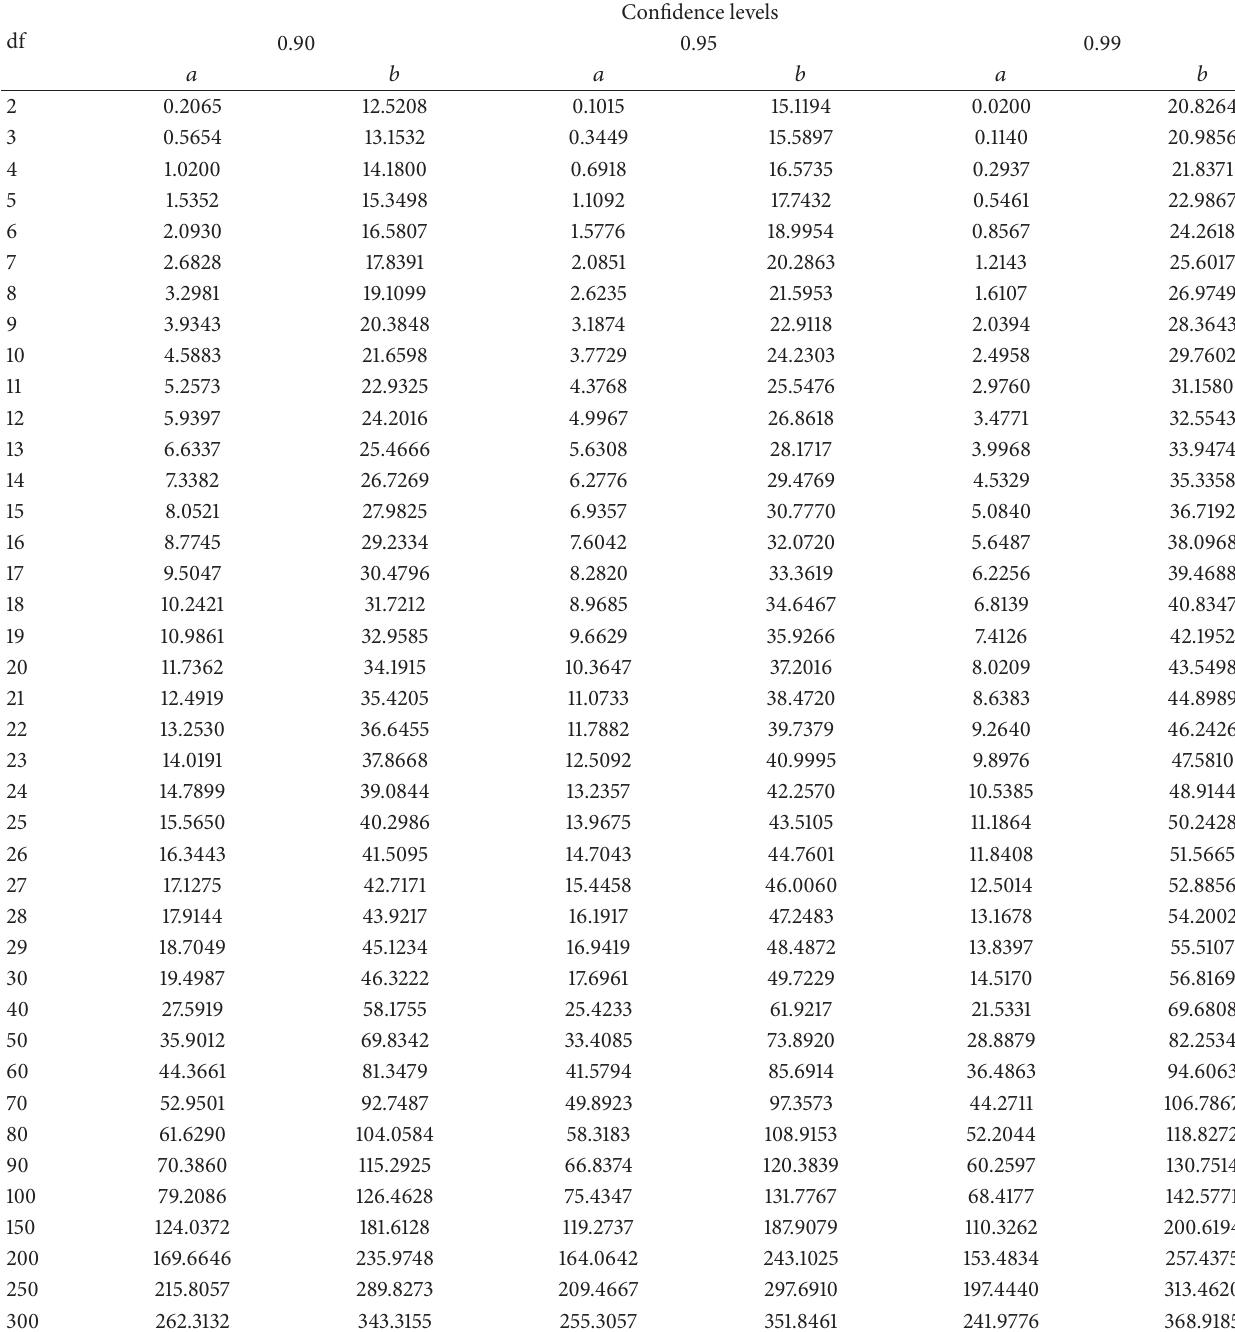
Table 1: The values of 𝑎 and 𝑏 for the shortest-length confidence interval for 𝜅 0